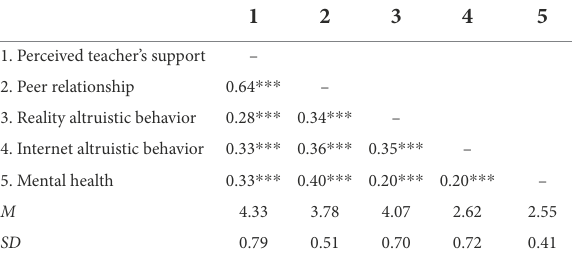
TABLE 1 Correlations among the key study